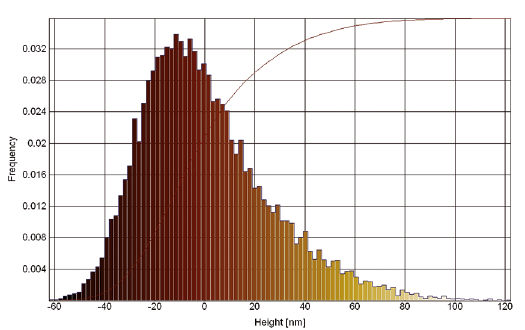
Figure 9: Height distribution histogram.